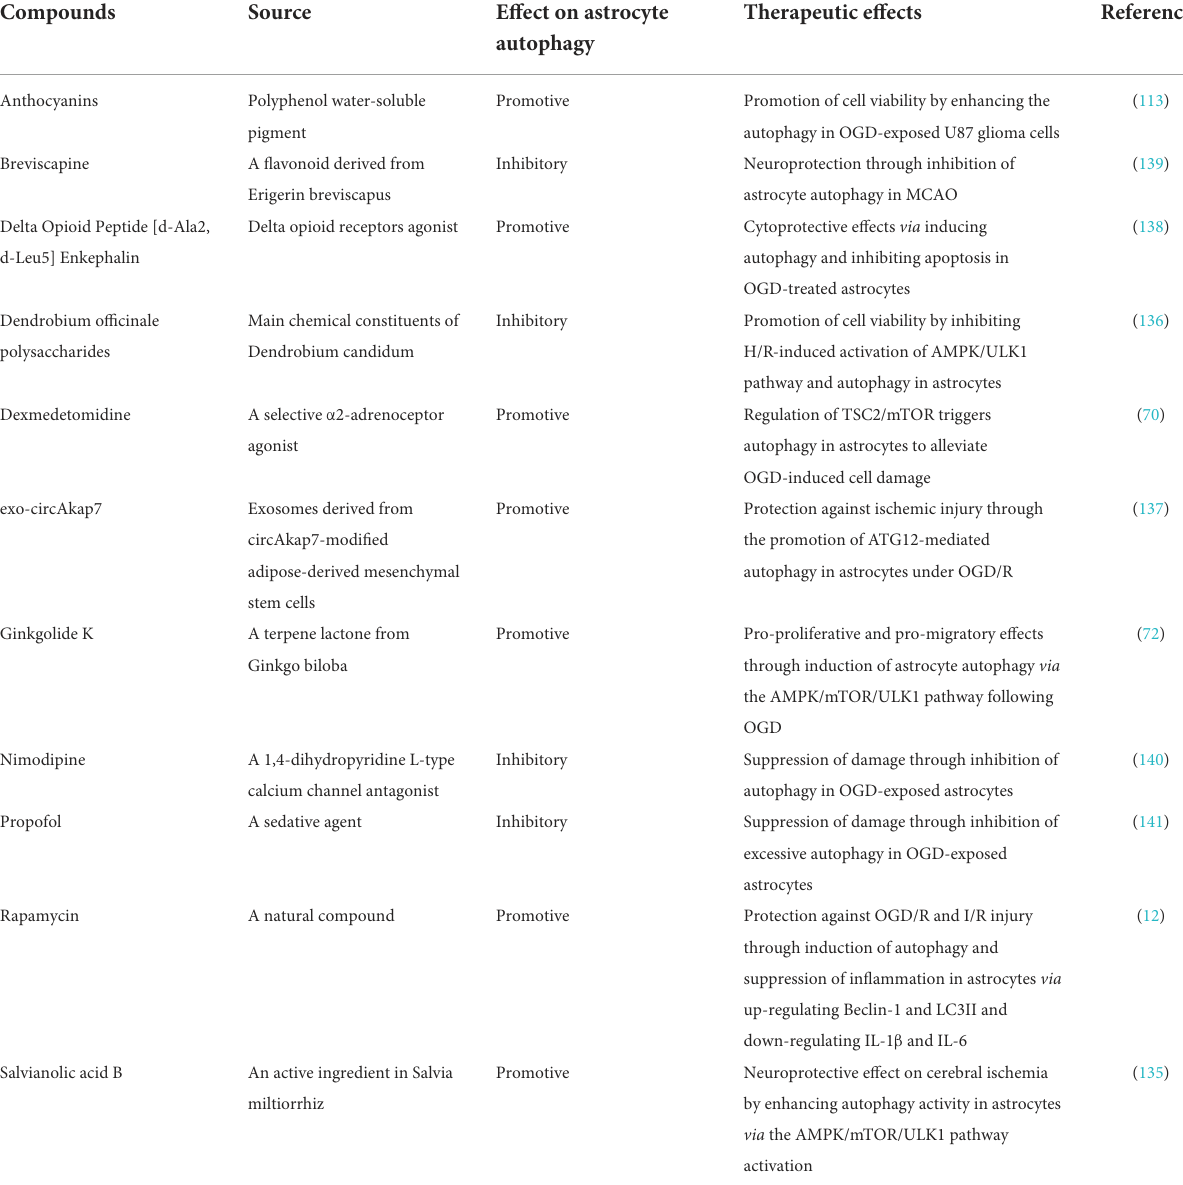
TABLE 2 Astrocyte autophagy-targeted drug therapies for ischemic stroke.